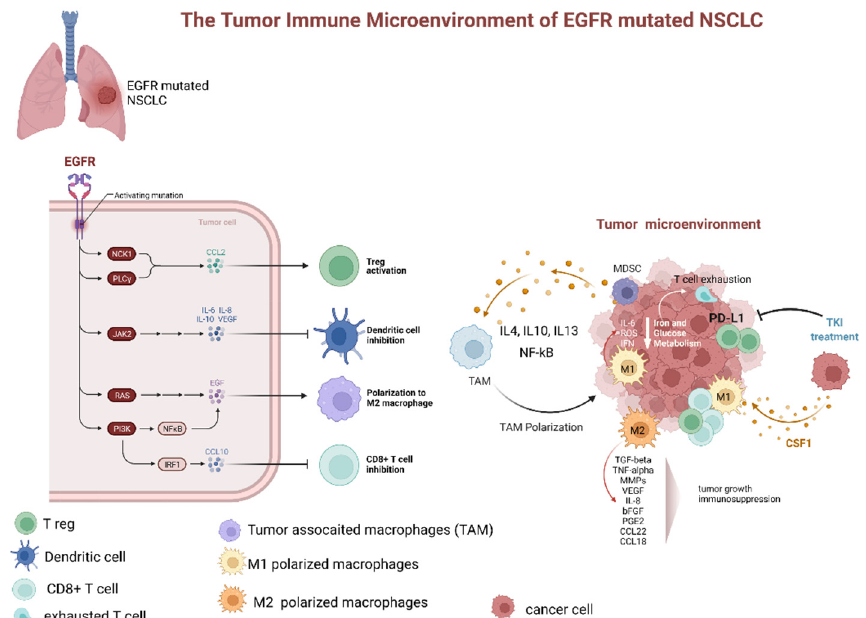
Figure 3. Dynamic changes of tumor microenvironment (TME) of EGFR-mutated NSCLC during tyrosine kinase inhibitor treatment. TME of EGFR mutated adenocarcinoma is typically character- ized by prevalence of M2 polarized macrophage, low levels of CD8+ cells, increased number of Treg, and upregulation of PD-L1. The latter, especially if associated with macrophage-mediated inflammation particularly through IL-6 and increased ROS levels, contributes to T-cell exhaustion. Additionally, several factors secreted by M2 polarized TAMs (as TGFbeta, TNFalpha, MMPs, VEGF, IL-8, bFGF, PGE2, CCL22, and CCL18). These factors contribute to tumor progression and im- munodepression. The TKI treatment has been associated with a decrease in PD-L1 expression, lowering of Treg, and promotion of TAM polarization from M2 to M1 phenotype. Abbreviations: